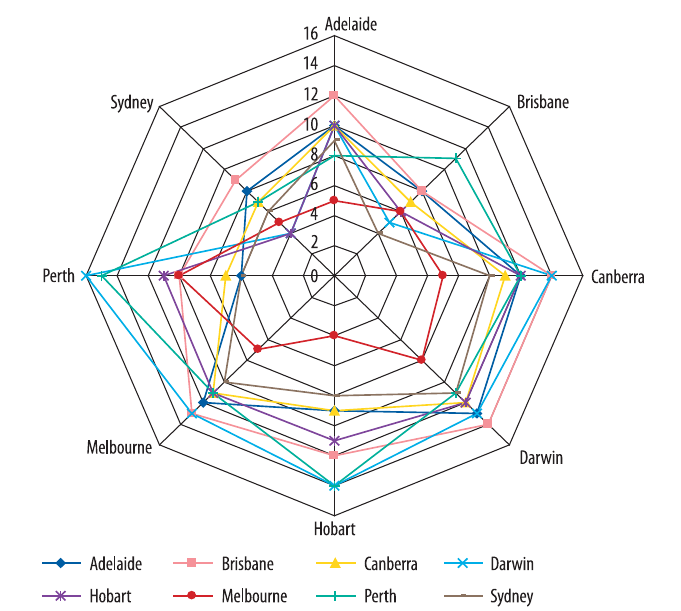
Figure 3. Lagged terms when fi rst reaching a value of impulse response of less than